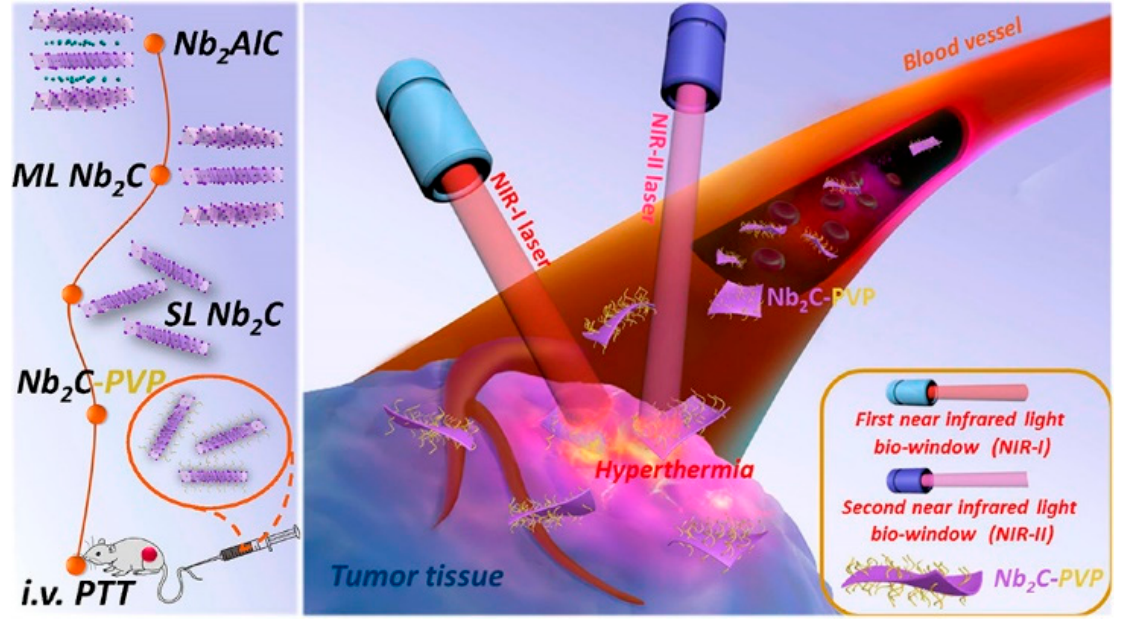
Figure 12. 2D biodegradable Nb 2 C (modified with PVP) schematic illustration for in vivo photother- mal tumor ablation in NIR-I and NIR-II bio-windows. Reprinted with permission from Ref. [90].